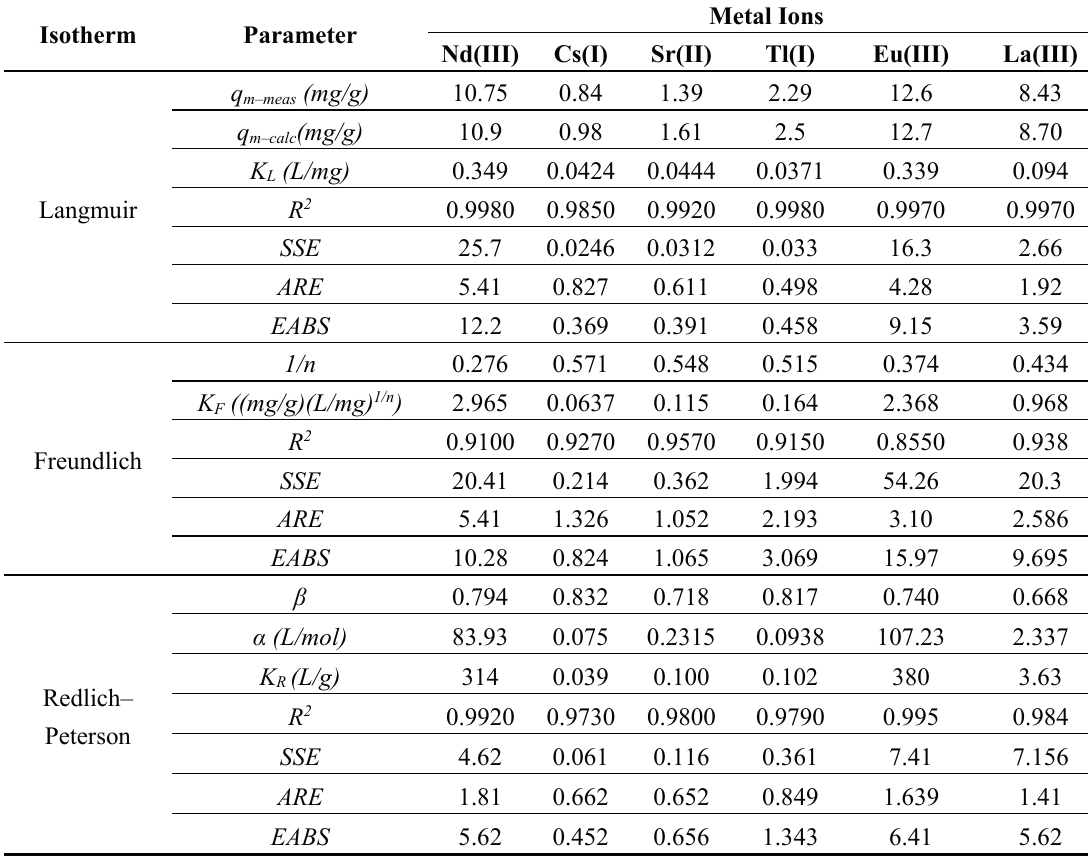
Table 1. Isotherm parameters obtained for the sorption of metal ions onto bone powder.